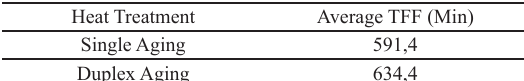
Table 1. Average